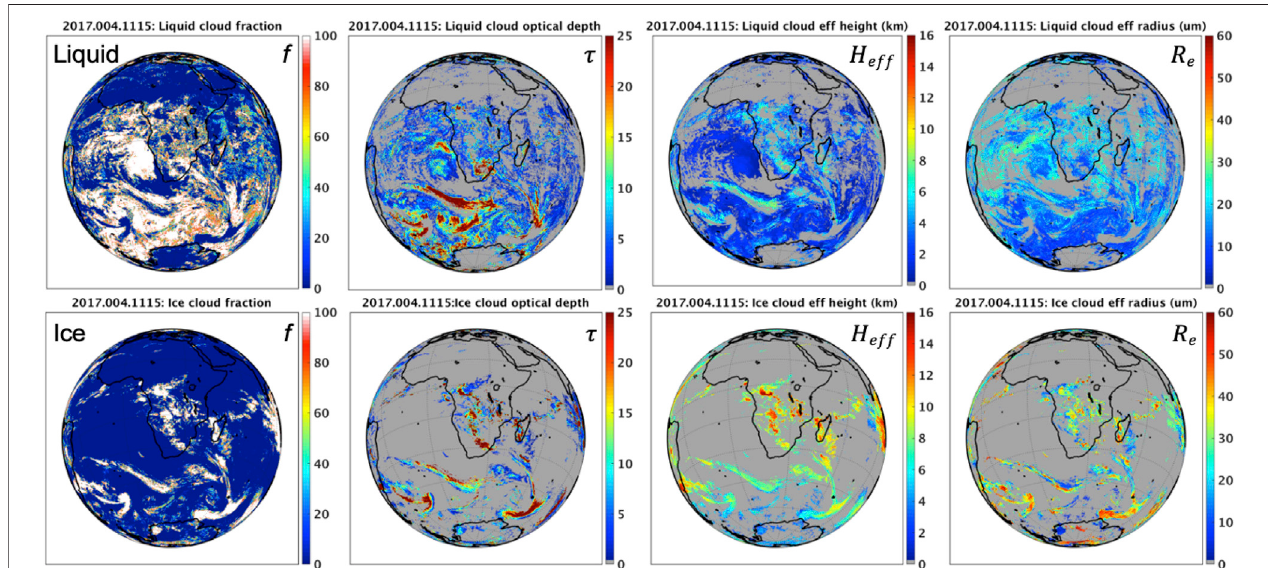
FIGURE 4 | Cloud properties retrieved from the LEO/GEO EPIC composite for January 4, 2017 at 11:15 UTC. Figures from left to right show cloud fraction (%), cloud optical depth, cloud effective height (km), and cloud effective droplet radius ( μ m ) for liquid phase clouds (top row) and ice phase clouds (bottom row) .